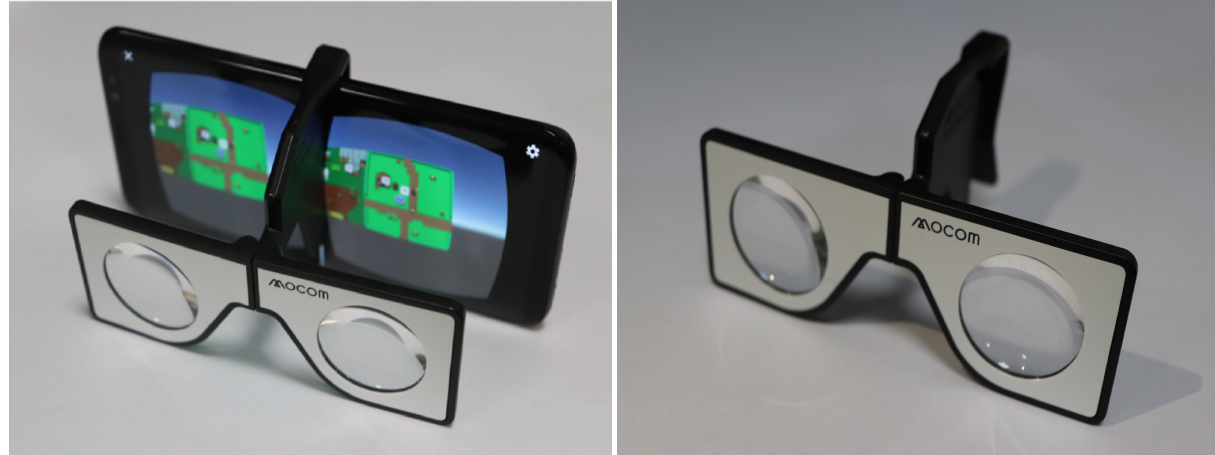
Figure 2. Smartphone based XR with clip-on lenses ( left ), the lenses itself ( right